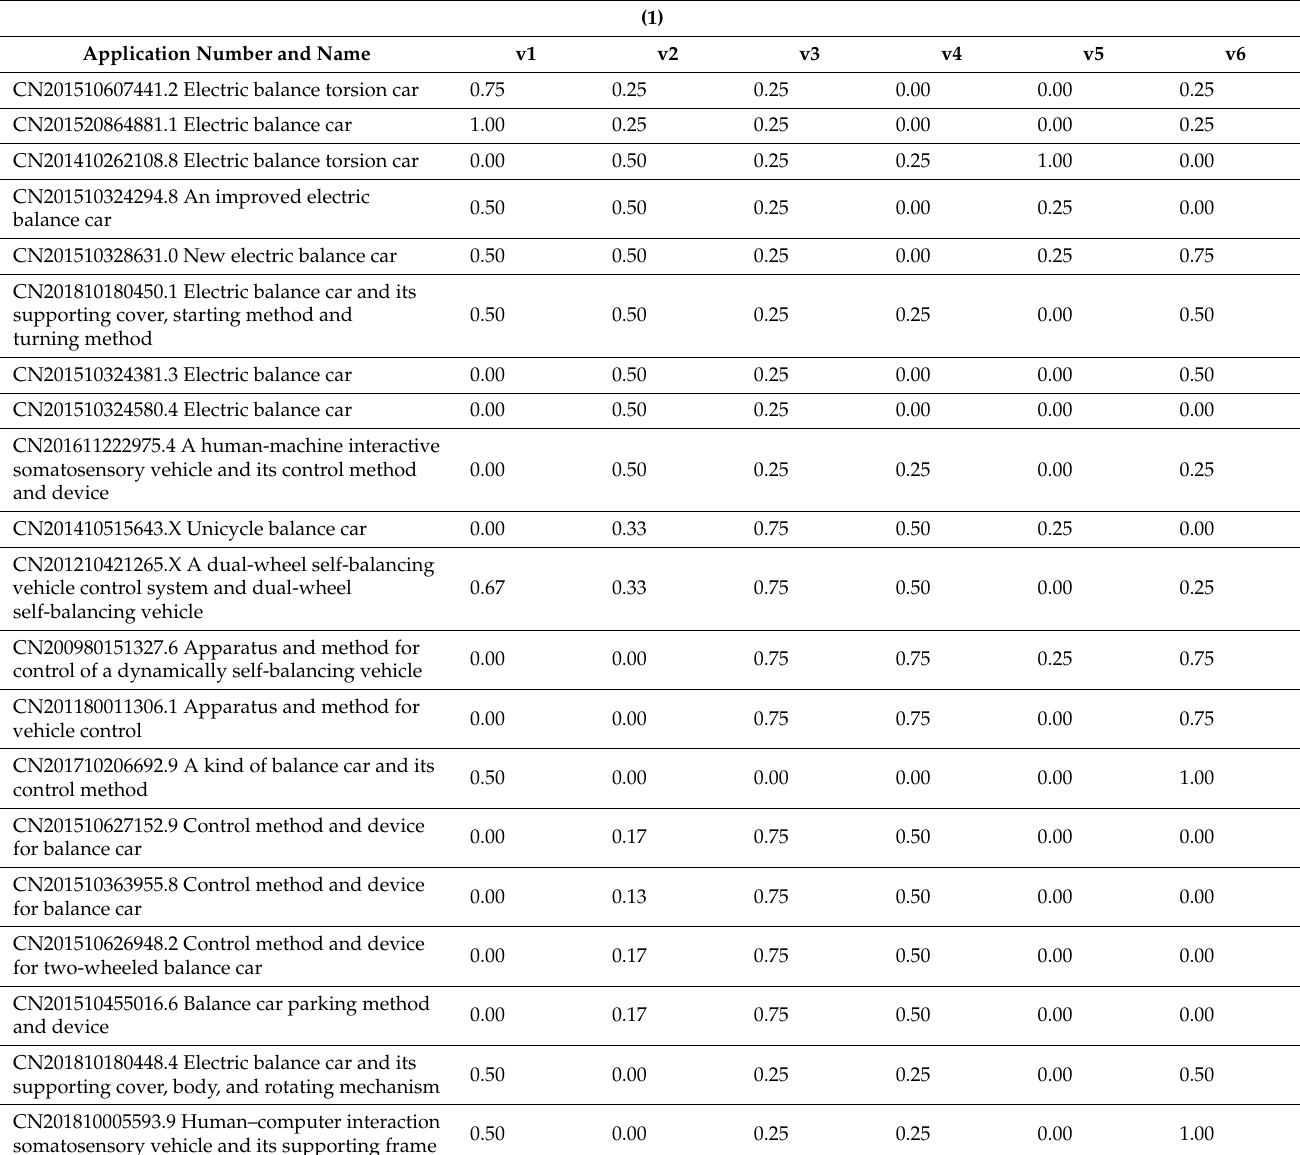
Table 15. ( 1 ) Normalization matrix of patent data of self-balancing vehicle. ( 2 ) Normalization matrix of patent data of self-balancing vehicle